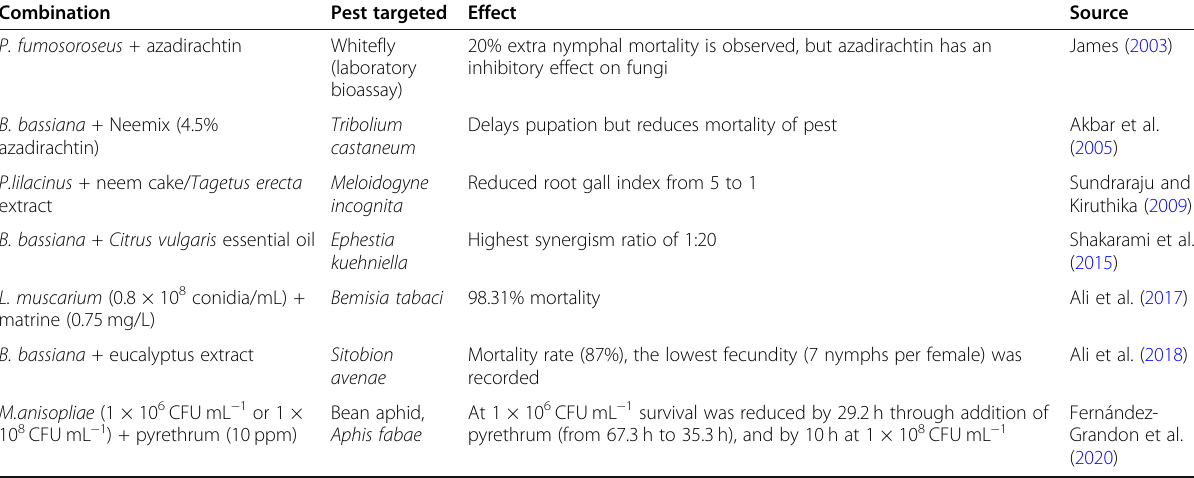
Table 2 Some botanicals and entomopathogenic fungi combinations